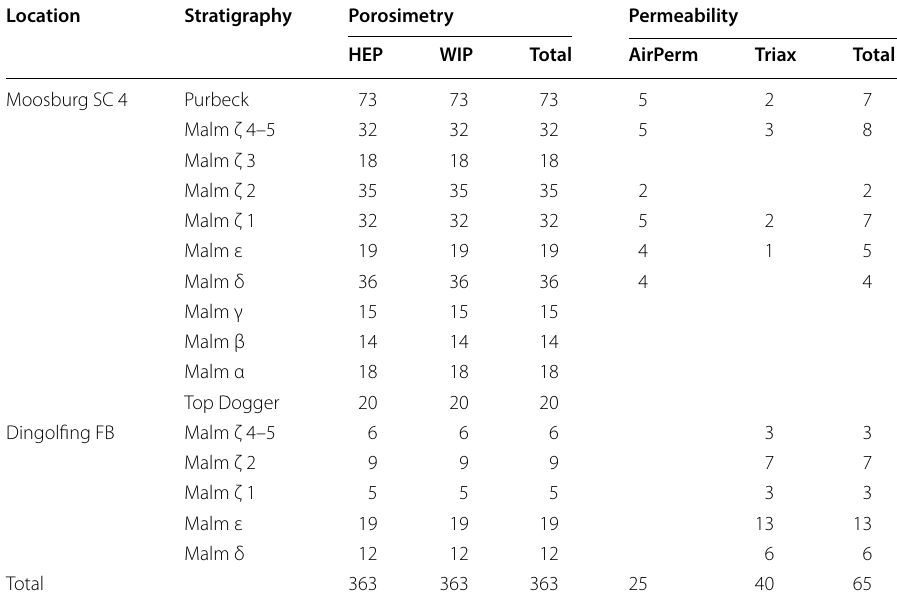
Table 1 Overview of rock samples and the corresponding measurement